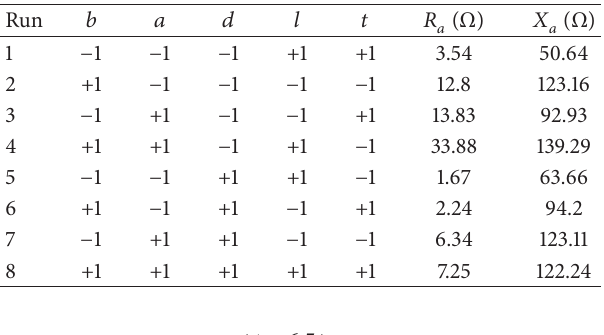
Table 3: The 2 5 – 2 orthogonal fractional experiment and the simu- lated results (at